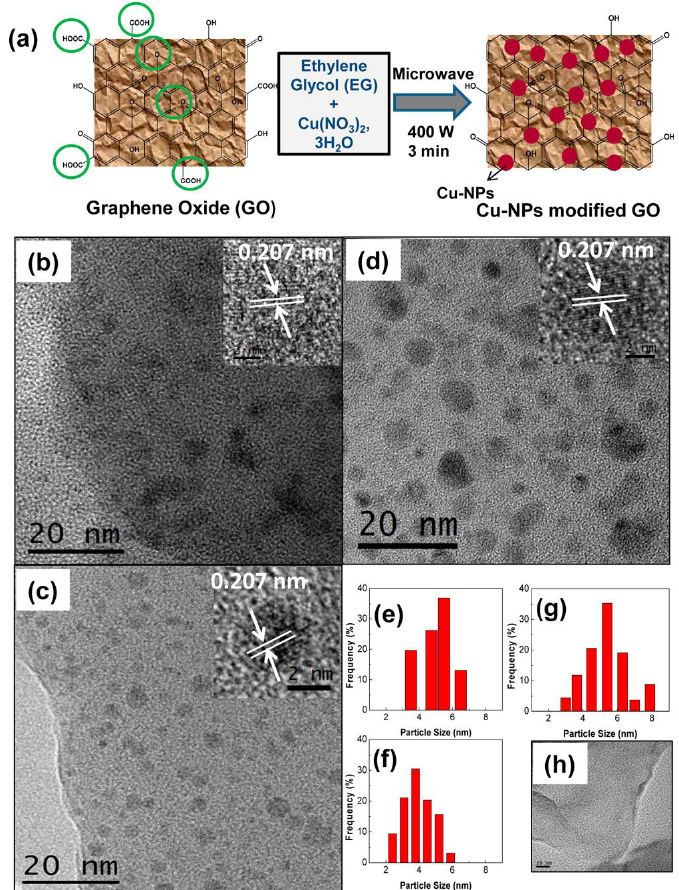
Figure 8. Scheme of the MW assisted synthesis process adopted to decorate GO with Cu NPs ( a ). Sections ( b − d ): TEM images of Cu/GO hybrids with 5, 10, and 15 wt % Cu, respectively. Inset: HRTEM image of single Cu-NP of the respective Cu/GO hybrid. Sections ( e – g ): size distribution of Cu-NPs in Cu/GO hybrids with 5, 10, and 15 wt % Cu, respectively. Representative TEM image of pure GO ( h ). Reprinted with permission from Shown, I.; Hsu, H.-C.; Chang, Y.-C.; Lin, C.-H.; Roy, P. K.; Ganguly,